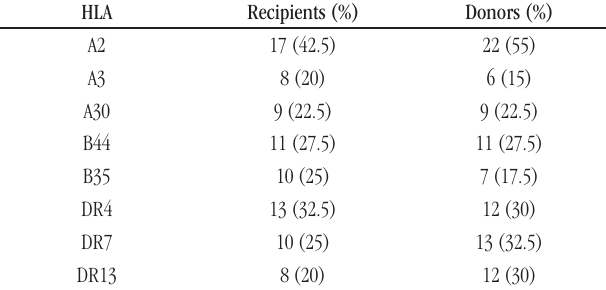
taBLE 2 − Distribution of the most frequent alleles in donors and recipients of kidney